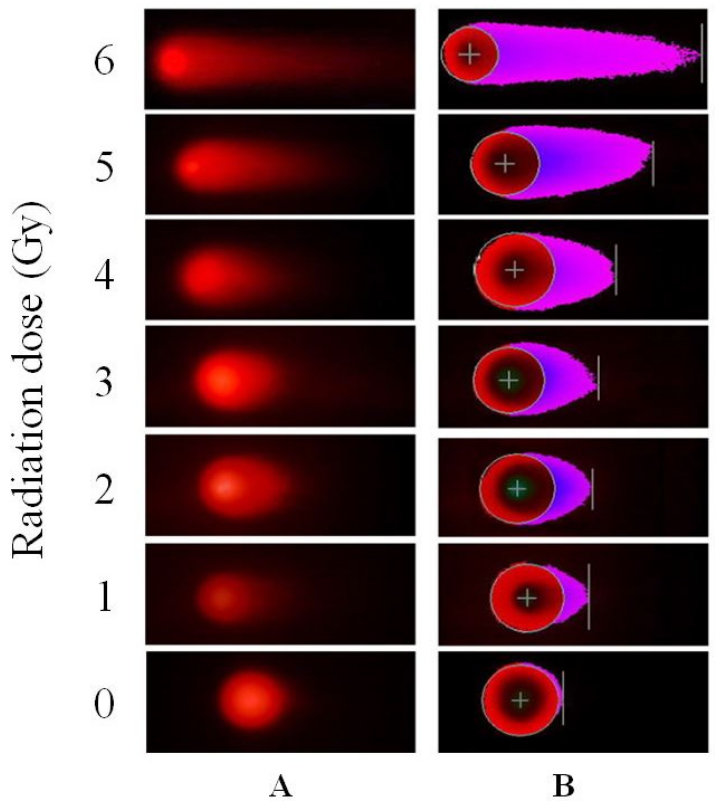
Figure 7. Comet images of lymphocytes after irradiation by γ -rays. ( A ): Original comet images; and ( B ): Comet images analyzed by CASP (CASP, Wroclaw,